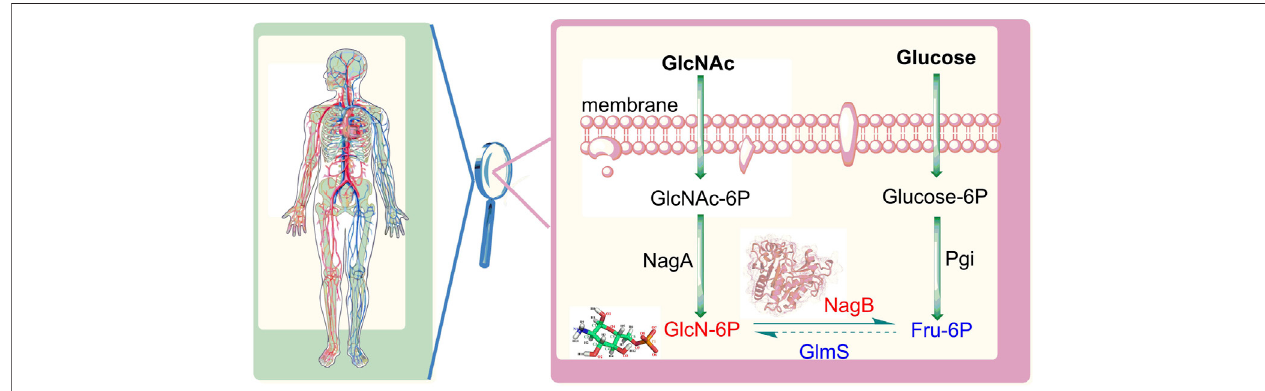
FIGURE 1 | Distribution of sugars mediated by glucosamine-6-phosphate deaminase (NagB) and glutamine-fructose-6-phosphate aminotransferase (GlmS). GlcNAc: N-acetylglucosamine, GIcNAc-6P: N-acetylglucosamine 6-phosphate; GlcN-6P: glucosamine-6-phosphate; Fru-6P: fructose 6-phosphate; Glucose-6P: glucose 6-phosphate; NagA: N-acetylglucosamine 6-phosphate deacetylase Pgi: glucose 6-phosphate isomerase.